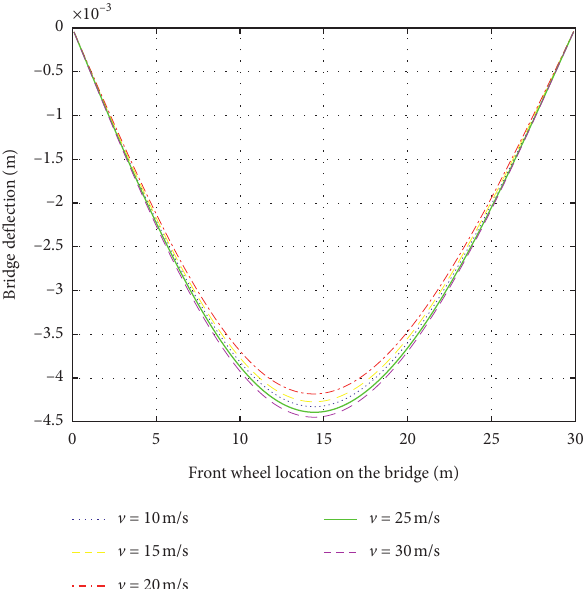
Figure 17: Displacement of the bridge with different vehicle velocities.